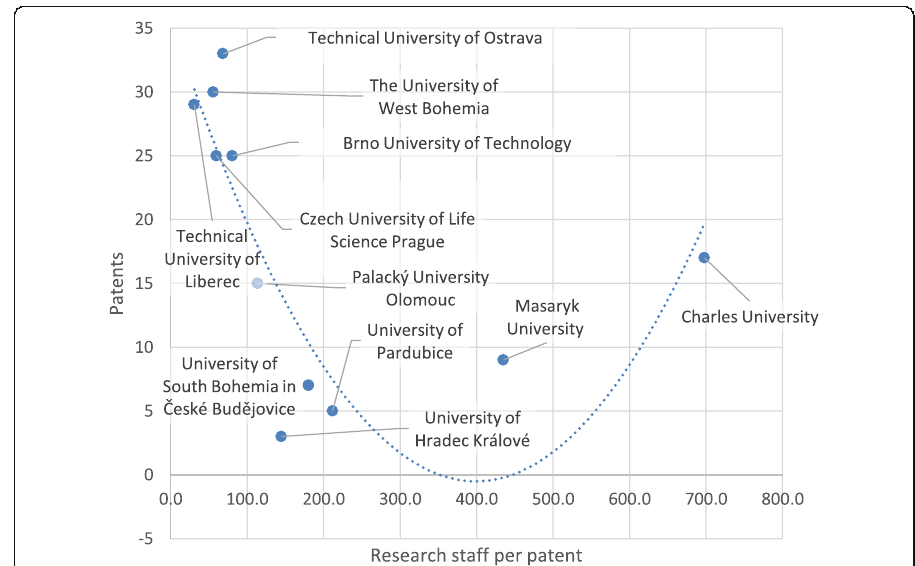
Fig. 3 Research staff efficiency impact on total patent output